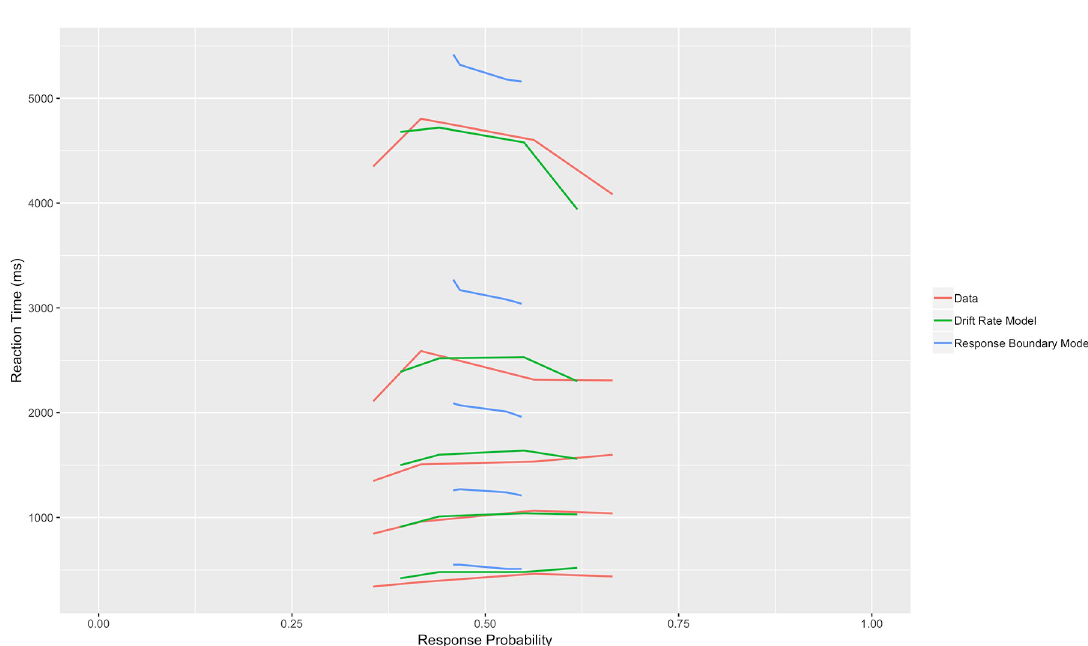
Fig 2. Drift rate vs. response boundary linear ballistic accumulator (LBA) models. Quantile probability plot comparing data and predictions from the drift rate and response boundary LBA models. Response probabilities for the four experimental stimuli are plotted on the x-axis, while five reaction time quantiles (the .9, .7, .5, .3, and .1 quantiles) are plotted on the y-axis. The drift rate LBA model achieved a markedly superior fit.